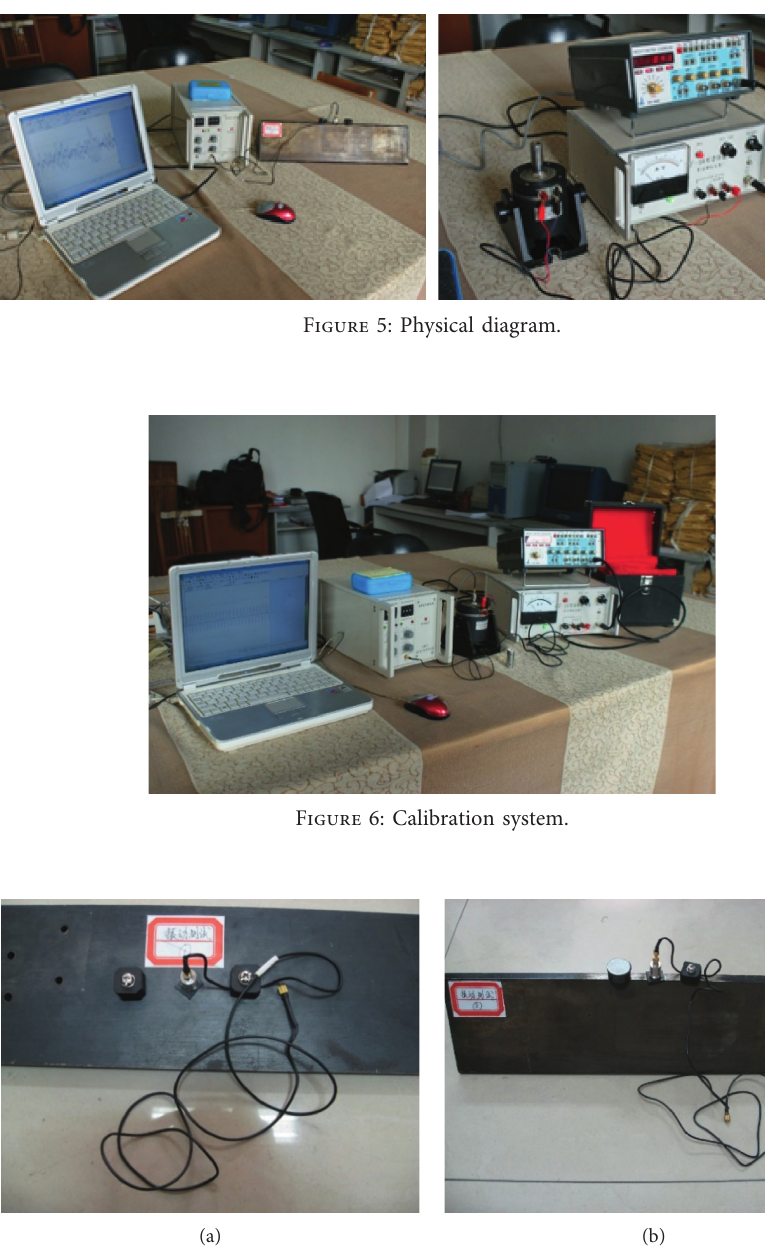
Figure 4: Connection diagram.